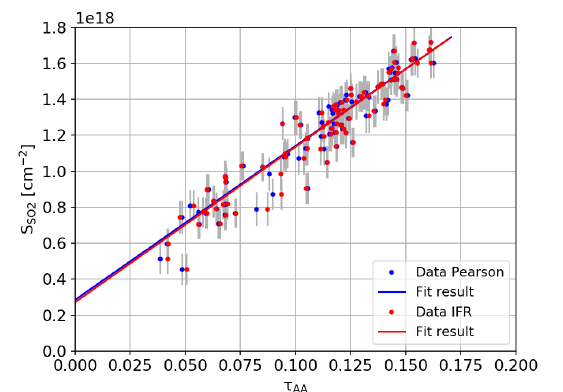
Figure 6. DOAS calibration curves. Plot showing example DOAS calibration data corresponding to the two different FOV parametrisations shown in Figure 7. The fit was performed using a first-order weighted polynomial fit. The weights were calculated using the relative errors ∆ S SO2 / S SO2 of the DOAS SO 2 -CDs. The y -axis offset is likely due to uncertainties in the DOAS retrieval (e.g., due to O 3 interference) and is compensated by the